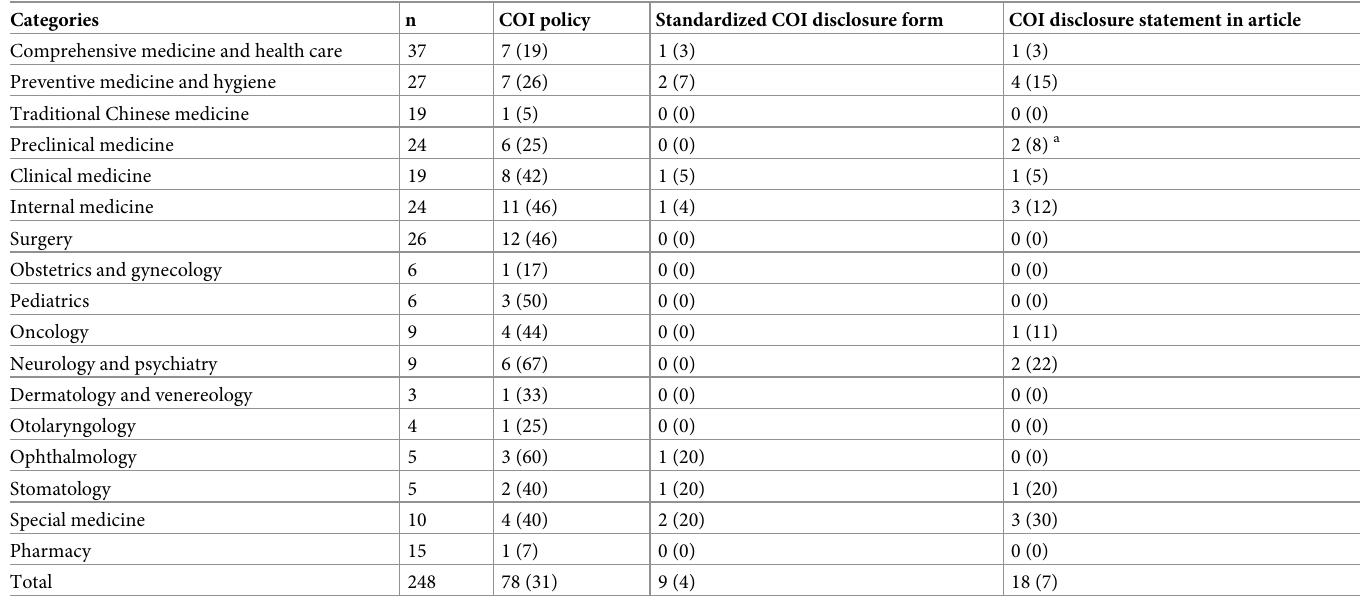
Table 1. Characteristics of COI disclosure policies among journals [n